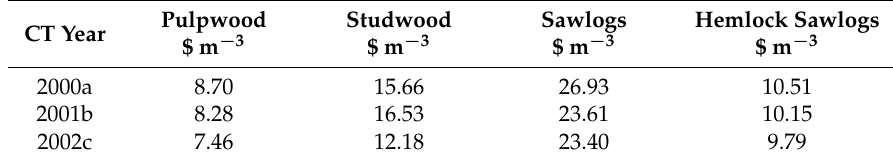
Table 3. Stumpage prices for spruce/fir pulpwood, studwood, and sawlogs, as well as hemlock ( Tsuga Canadensis (L.) Carri è re) sawlogs as used for CT revenue estimation. Conversion from $ tonne − 1 to $ m − 3 was done using a conversion factor of 0.87 tonnes m − 3